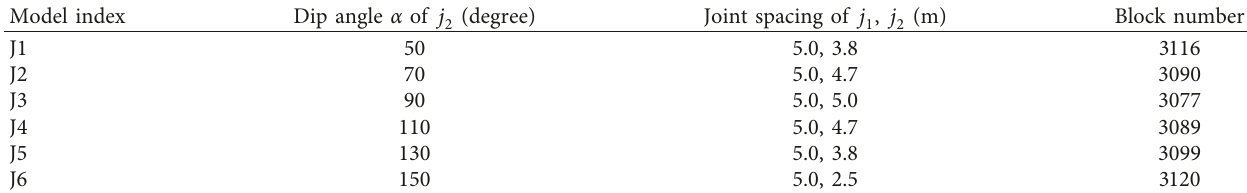
Figure 6: Geometric dimensions of the model and distributions of the measurement points Table 1: Rock joint and block number information in the six models.